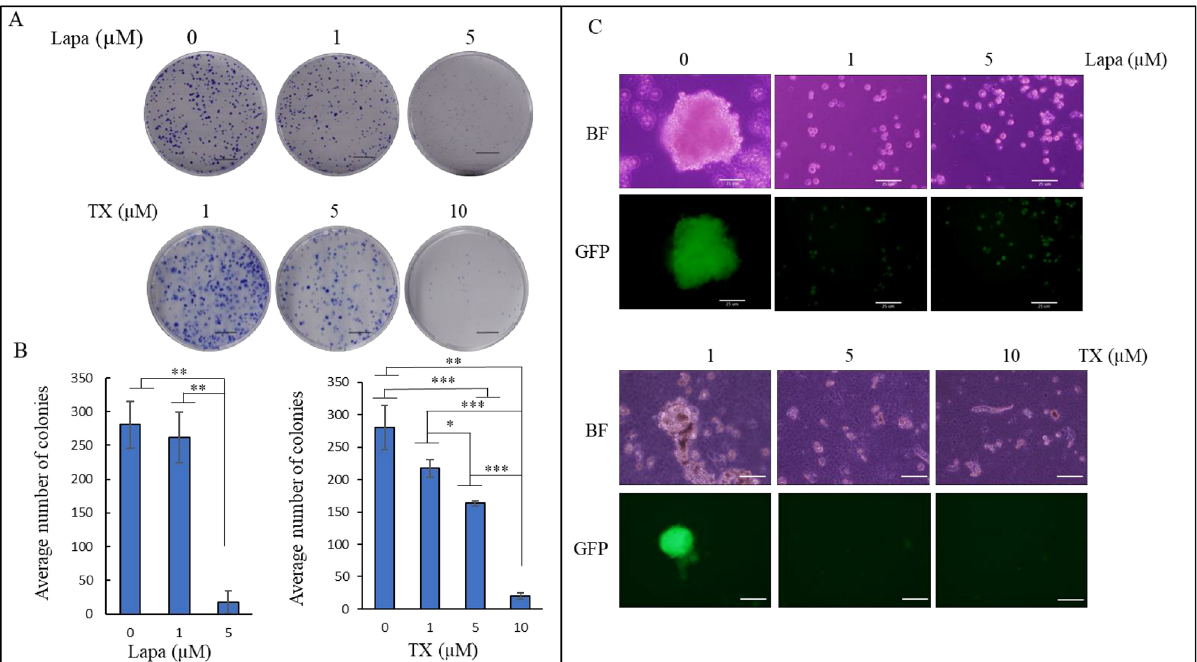
Figure 4. The effect of lapatinib and TX1-85-1 on the self-renewal ability of miPSCs cultured in CM. ( A ) Representative images of colonies formed by miPSCs cultured in different conditions. Scale bar = 1 cm. ( B) The bar graph depicts the average number of colonies after one week of culturing miPSCs in the CM supplemented with either 1 or 5 µM of lapatinib or with 1, 5 or 10 µM of TX1-85-1. Data were from three independent experiments (n = 3). ( C) Representative bright-field (BF) and fluorescence (GFP) images of a sphere formed by miPSCs cultured in the same treatment conditions as described above show inhibition of sphere formation ability by lapatinib and TX1-85-1. Scale bars = 25 µm. Experiments were repeated three